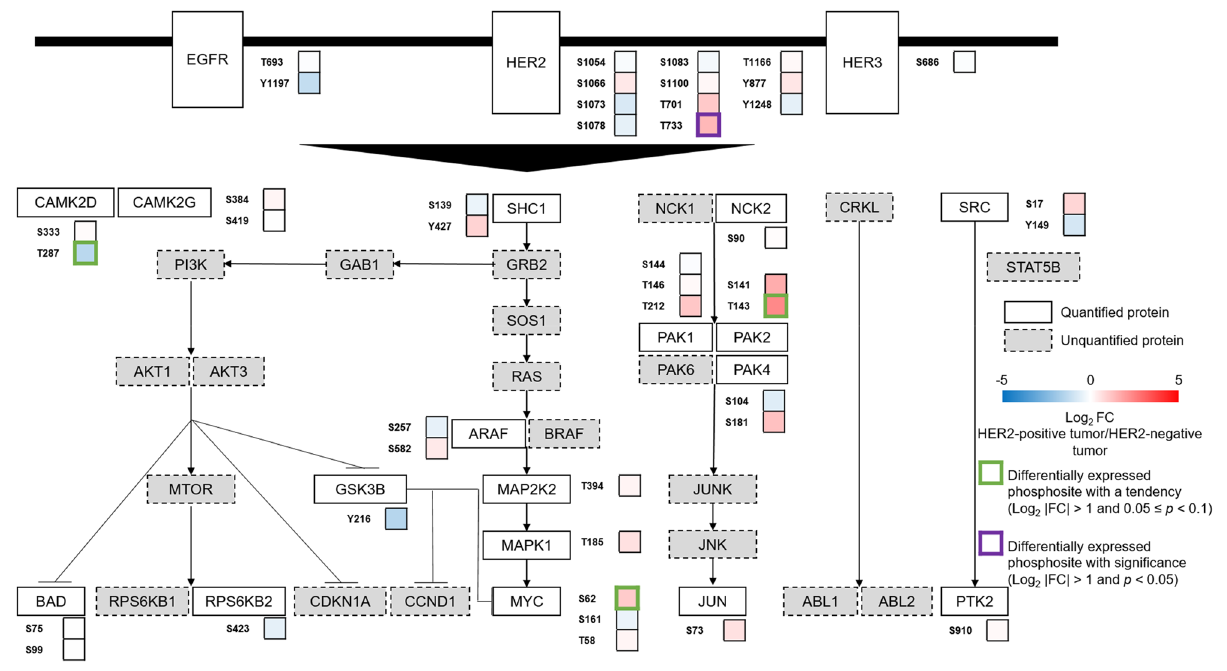
Figure 3. Dynamics of phosphosites in the ErbB pathway (the HER2-positive gastric cancer [pre-treatment] group versus the HER2-negative gastric cancer group). Proteins in the ErbB signaling pathway are selected from the KEGG database 65 . Proteins with quantified phosphosites are shown as white boxes with solid lines. Proteins without quantified phosphosites are shown as grey boxes with dotted lines. Differentially expressed phosphosites with significance (log 2 |FC| > 1 and p < 0.05) are depicted by a purple line. Differentially expressed phosphosites with a tendency (log